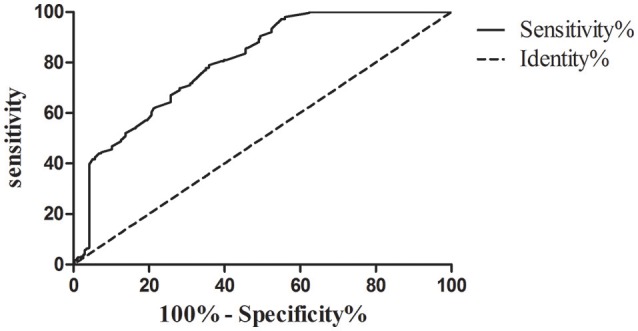
ROC curve analysis used to calculate the best cut-off point of serum iron level for differentiating the survival of patients with hepatocellular carcinoma. Best cut-off point of serum iron levels as 15.1 μmol/l (sensitivity%, 78.97% and specificity%, 64.07%; AUC [SE], 0.801 [0.018], 95% confidence limits range, 0.767–0.836, P < 0.0001).